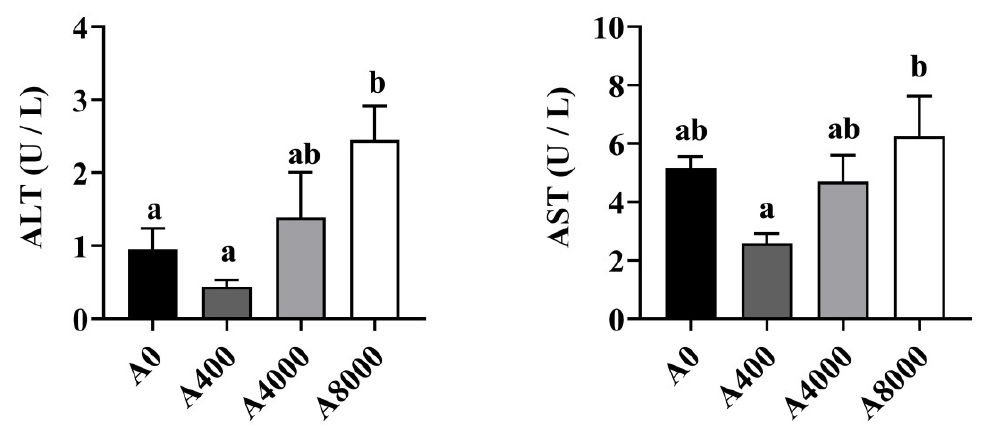
Figure 1. Plasma Effects of dietary Atractylodes macrocephala polysaccharide (AMP) on plasma ALT and AST. ALT: Alanine aminotransferase; ALT: Aspartate aminotransferase. Data are shown as mean ± SEM ( n = 6). Different lowercase letters represent significant differences among all groups ( p < 0.05).